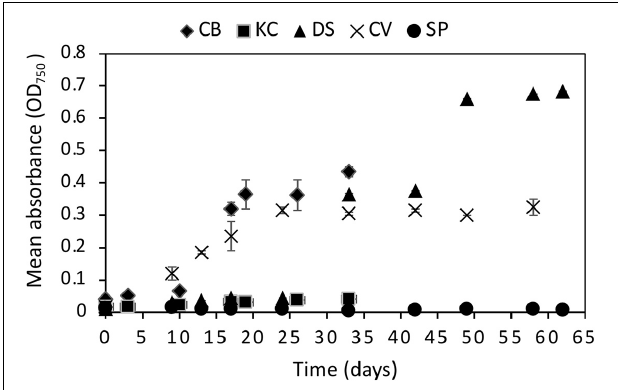
FIGURE 2 | Growth curves of all five algae Chloromonas brevispina (CB), Kremastochrysopsis austriaca (KC), Chlorella vulgaris (CV), Spirulina plantensis (SP) and Dunaliella salina (DS) grown at low pressures of 670 ± 20 mbar plotted as a mean of absorbance measured by optical density measurement at 750 nm. Error bars represent the range in OD 750 values between duplicate experiments. Where error bars are not visible, they fall within the